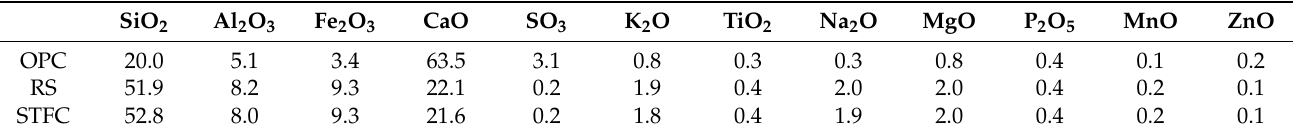
Table 3. Concentrations (%) of the major oxide elements for OPC, RS, and STFC.